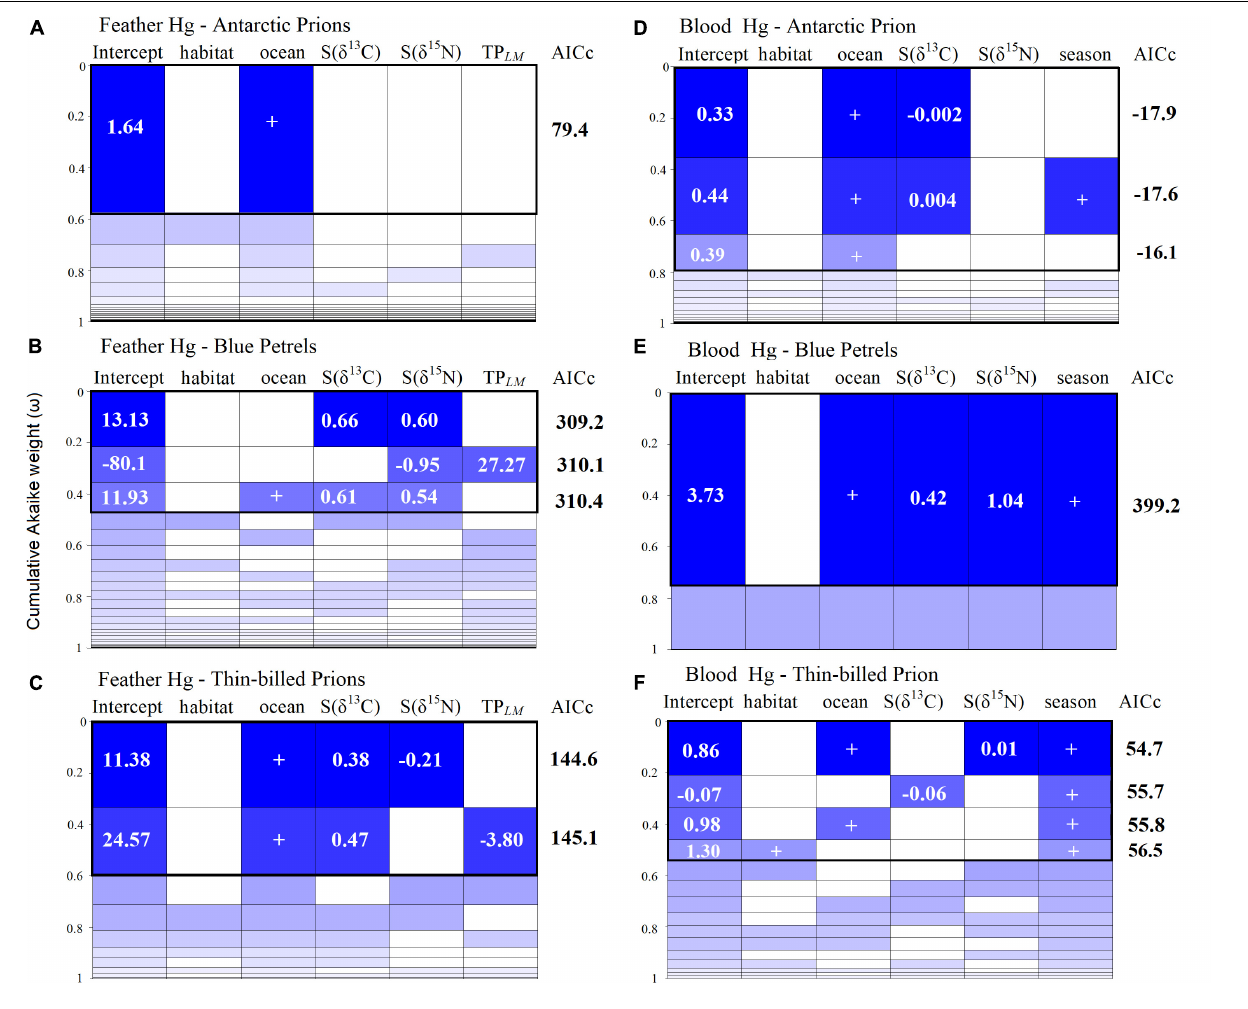
FIGURE 6 | Summary of GAM model selection (dredge function in the R package MuMIn) on the full models for feathers (A–C) : gam(THg.feathers ∼ s(TP_est) + s( δ 13 C.feathers) + s( δ 15 N.feathers) + habitat + ocean), and for blood (D–F) : gam(THg.blood ∼ s( δ 13 C.blood) + s( δ 15 N.blood) + season + habitat + ocean). The selected best models are outlined, and their AICs given on the right. Blue cells note the retained parameter, with coefficients reported in white